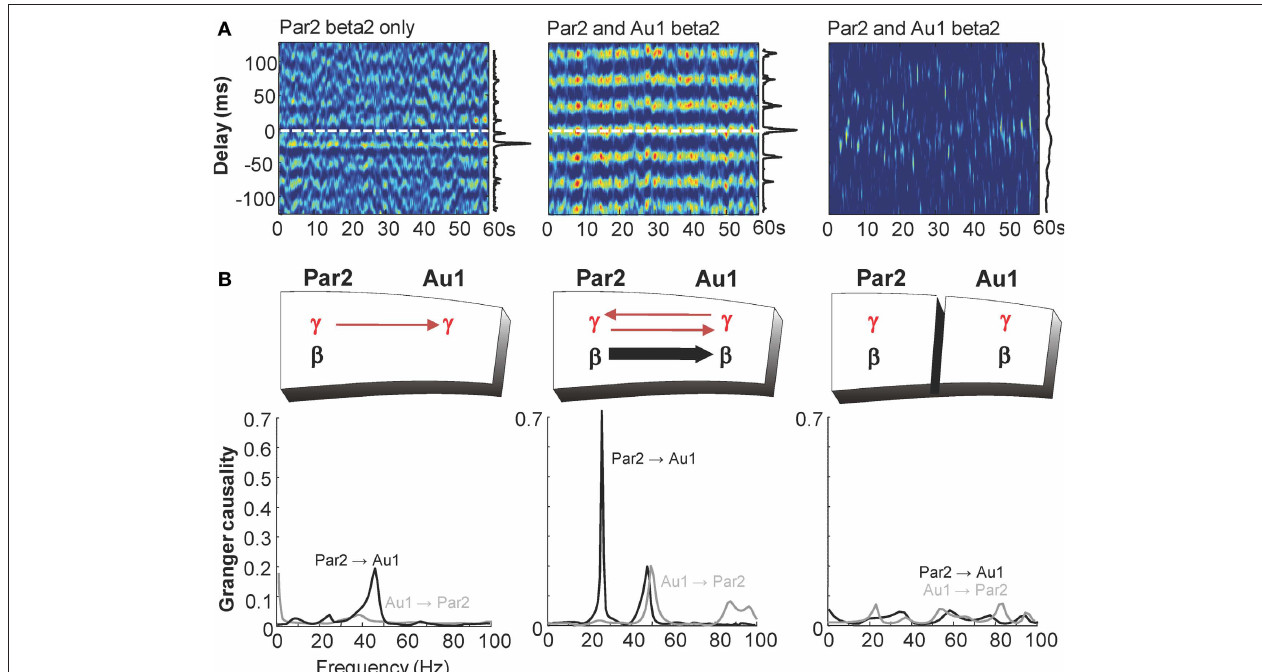
FiGurE  | Cholinergic neuromodulation is essential for Au-par coherence at beta frequencies. (A) Windowed cross correlograms of 60 s epochs of field potential recordings from layer 5 of association cortex (par2) and primary auditory cortex (Au1) in conditions where beta2 rhythms are generated only in par2 (kainate bath application), and present in both par2 and Au1 (kainate and carbachol bath application) in intact slice and with full-thickness cut between par2 and Au1. Vertical graphs along side show pooled histograms of phase relationship measured as the position of the peak in each cross correlation window. Note the peak phase relationship corresponds to gamma frequencies with par2 beta alone and beta frequency when both areas generate this rhythm. Separation of areas